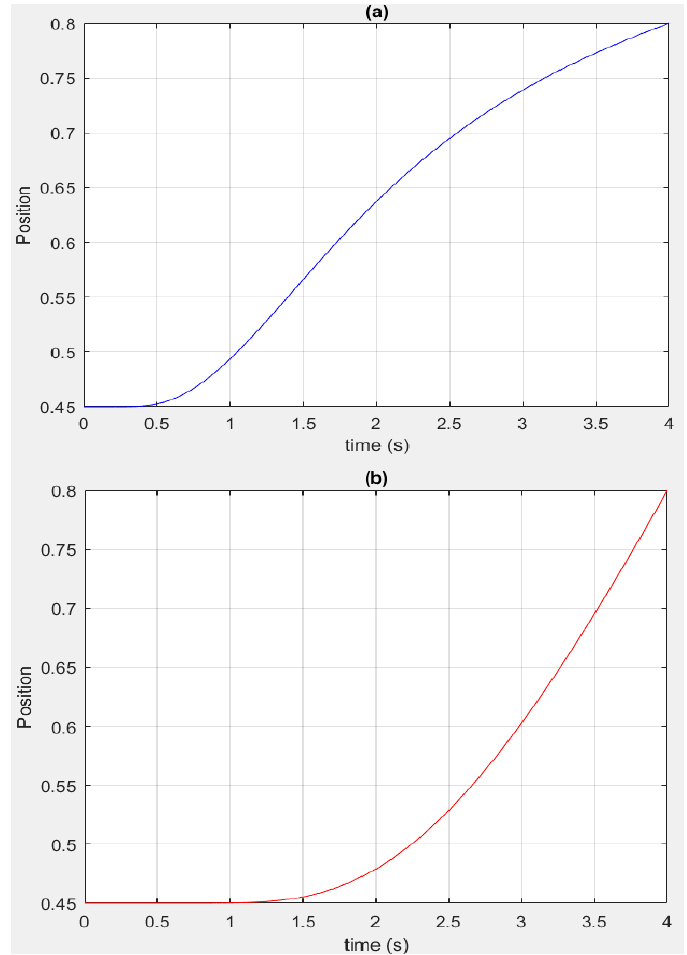
(𝑥) for when 𝑛 = 2 and 𝑛 = 12 ( b ) in order to obtain a (cid:3085)(cid:3028)(cid:3047) (cid:3294)